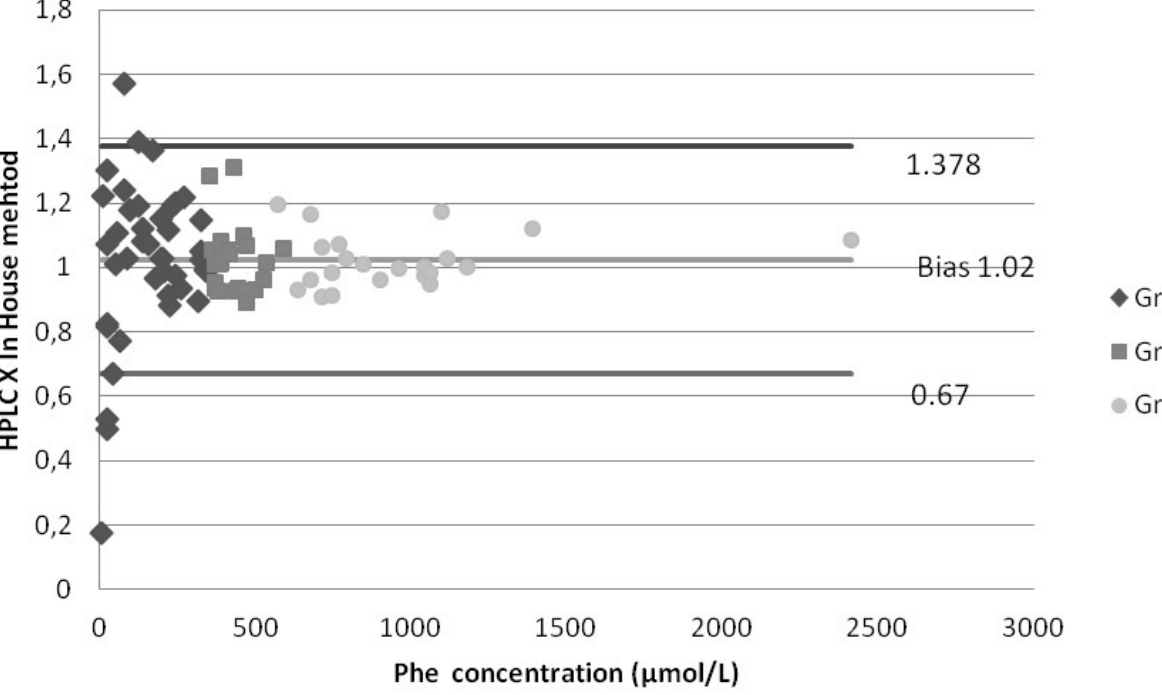
Figure 3. Ratio of phenylalanine (Phe) concentration in dried blood spots measured by the in-house method (method A) and by high- performance liquid chromatography (HPLC) (n = 89 blood samples). Group 1: <360.0µmol/L; Group 2: >360.0 µmol/L and <600.0 µmol/L; Group 3: > 600.0